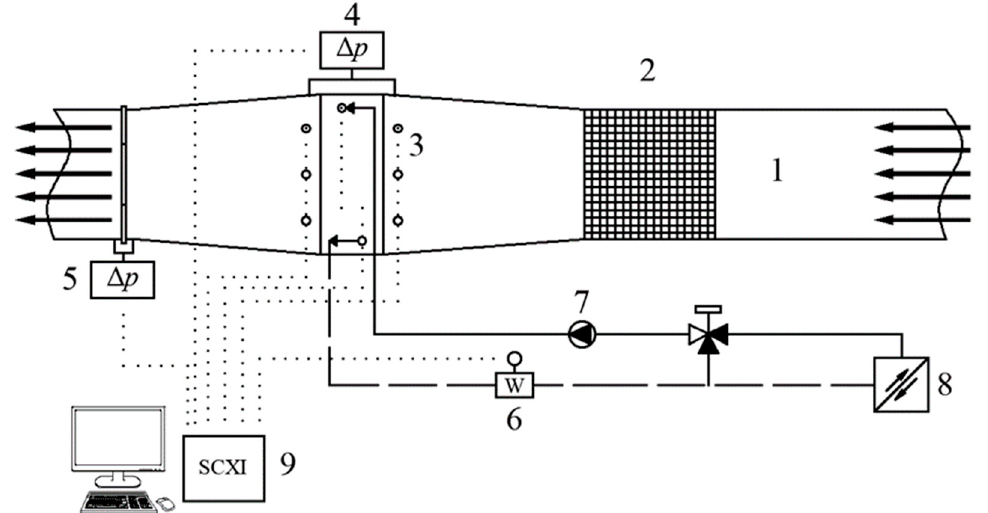
Figure 8. The experimental line: (1) air ducts, (2) flow straightener, (3) heat exchanger test section, (4,5) differential pressure sensors, (6) water mass flow meter, (7) water circulating pump, (8) heating source, (9) data acquisition.